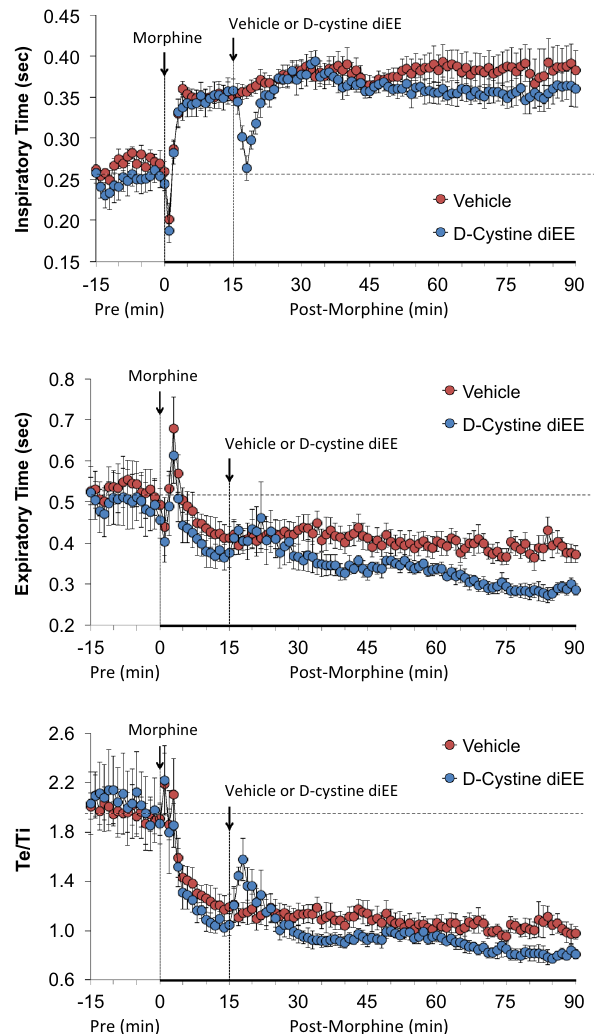
Figure 2. Changes in inspiratory time (top panel), expiratory time (middle panel) and expiratory time/ inspiratory time (Te/Ti) (bottom panel) in freely moving rats upon (a) injection of morphine (10 mg/kg, IV) and subsequent injection of vehicle (saline) or d-cystine diethyl ester (d-cystine diEE, 500 μmol/kg, IV). The data are presented as mean ± SEM. There were 9 rats in each